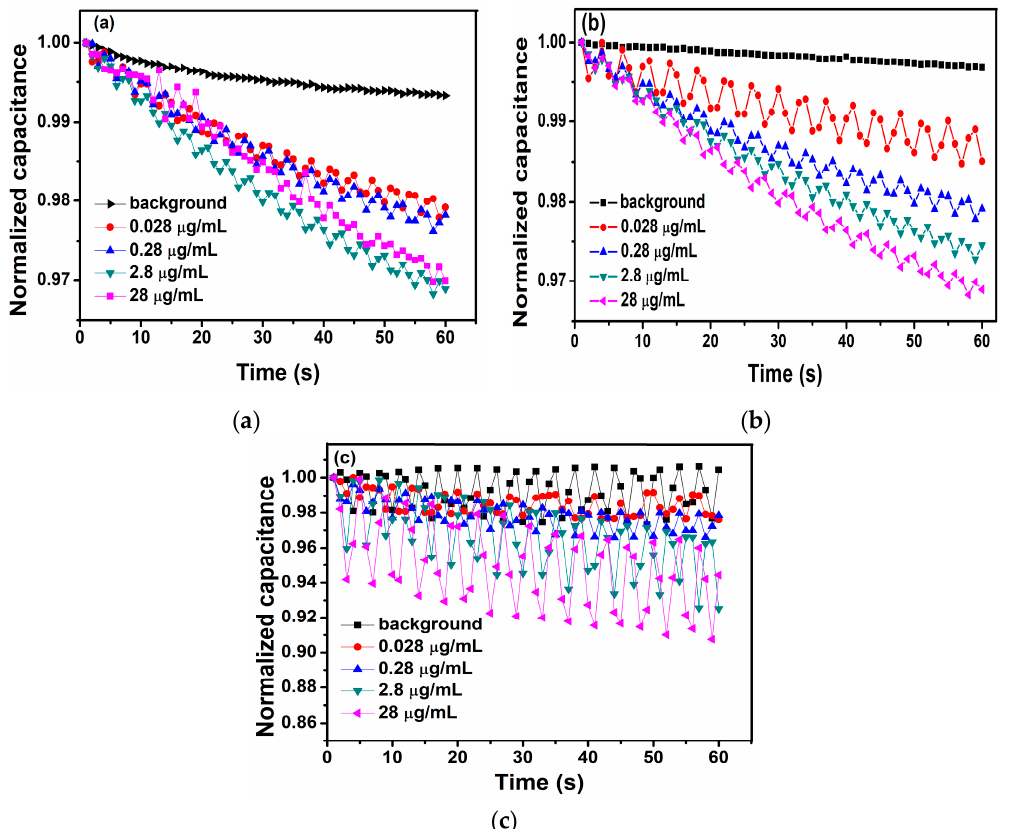
Figure 2. The relationship between the normalized capacitance and different concentrations of BPA with a 10-kHz AC signal of different voltages (( a ) 100 mV, ( b ) 600 mV, and ( c ) 1.1 V) applied to the interdigital electrodes.